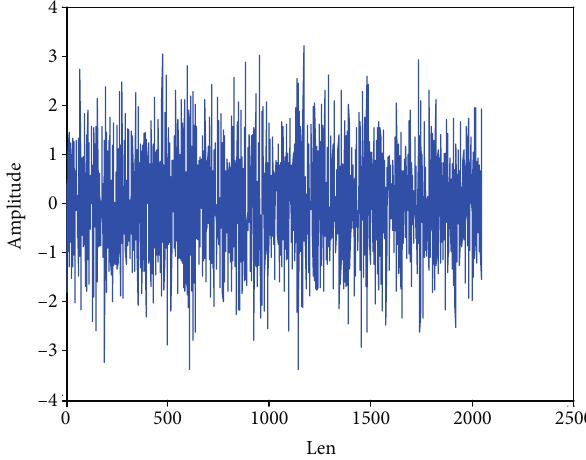
Figure 8: Signal time series with no fl utter.